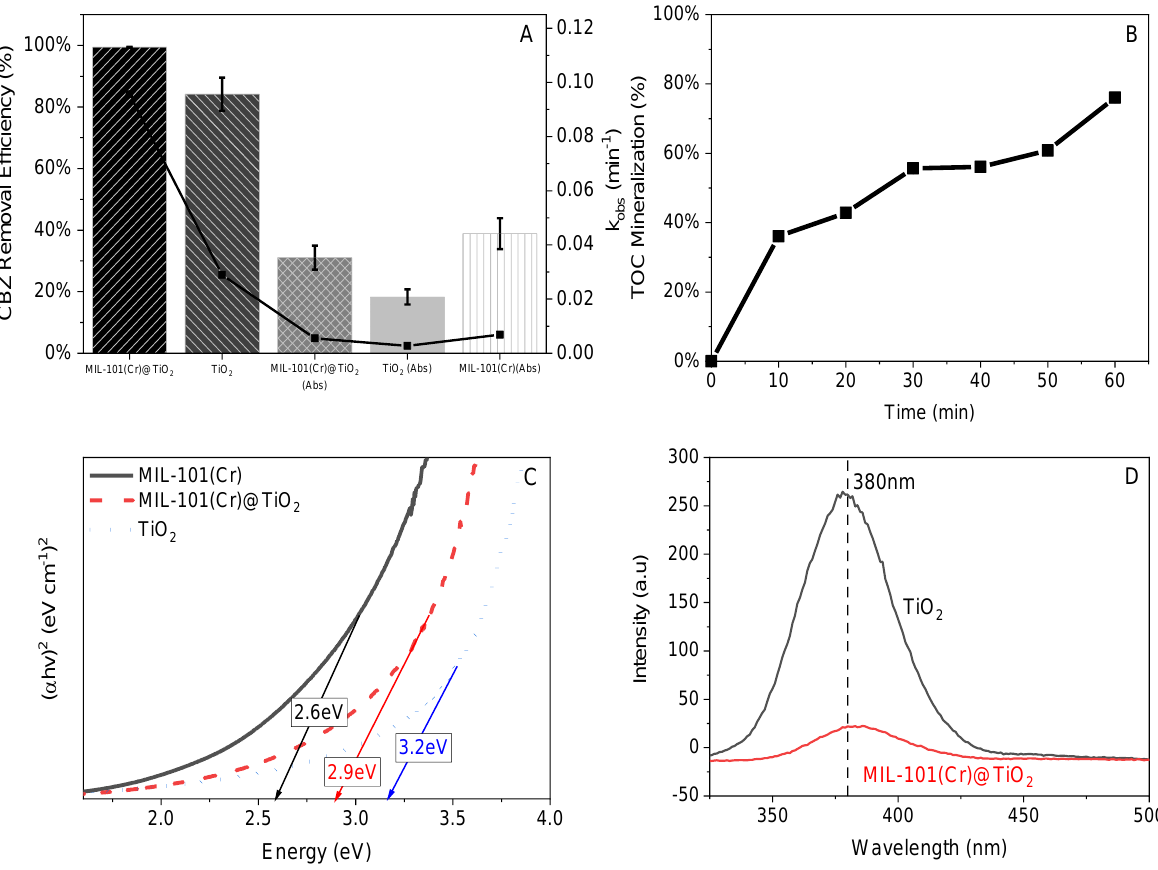
Figure 6. ( A ) CBZ removal efficiency and rate constants of CBZ degradation (min −1 ) for various different samples; ( B ) TOC mineralization (%) of CBZ using UV − A/MIL − 101(Cr)@TiO 2 ; ( C ) Tauc plot of MIL − 101(Cr), MIL − 101(Cr)@TiO 2 , and TiO 2 ; and ( D ) fluorescence emission spectrum of MIL − 101(Cr)@TiO 2 and TiO 2 .